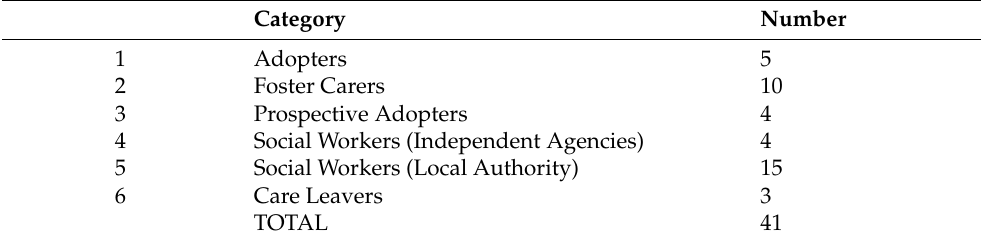
Table 1. No. of research participants by